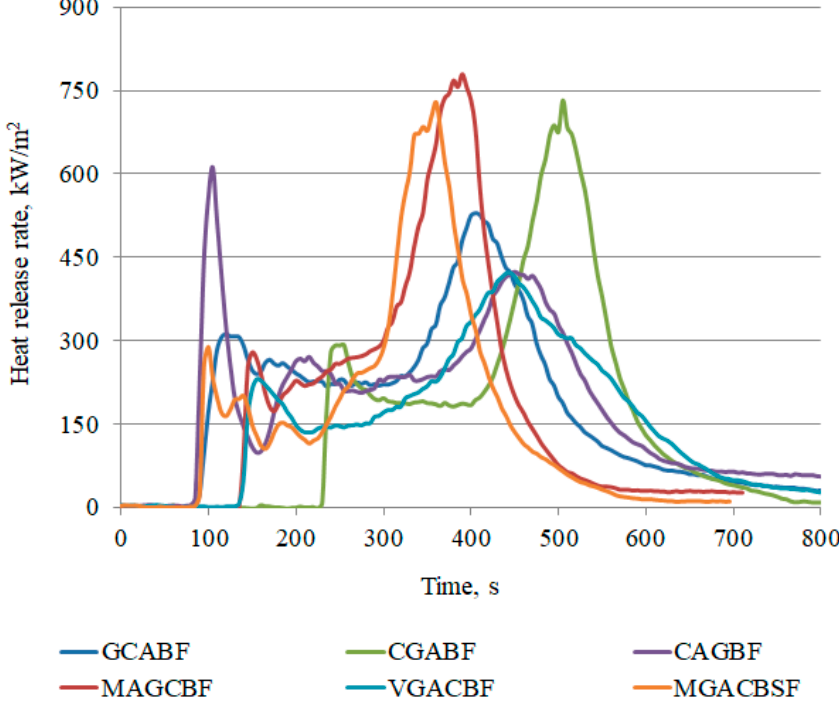
Figure 7. Representative curves of heat release rate of the EP-based composites. The time to ignition (TTI), which defines the time required for the ignition and main- tenance of the flame over the sample surface [29], achieved 94 to 142 s, and only for CGAB was significantly higher (172 s). However, the standard deviation in the case of these com- posites was also the highest. It should be emphasized that no significant trend associated with the sequence of fabrics was observed. On the other hand, the heat release rate, as the most evaluative factor among the fire properties, was ranging from 454 to 706 kW/m 2 , and the lowest values were obtained for composites with glass fabrics (GCABF) or vermiculite powder with glass fabric (VGACBF) as the outer layer. Since the amount of the epoxy resin, which is the most flammable component in investigated materials, was similar, it confirms the crucial influence of the type, form, and sequence of fabrics. For example, the replace of carbon fabrics with glass ones in CGCBF and GACBF composites decreased the pHRR by 38%, while glass spheres by vermiculite in MGACBSF and VGACBF decreased by 26%. This may be connected with the release of water, physisorbed in the vermiculite, that occurred due to the external heat flux impact and led to the exfoliation of V at an elevated temperature. Vermiculite, with a structural formula (Mg,Fe,Al) 3 (Al,Si) 4 O 10 (OH) 2 · 4H 2 O), is known for its flame retardant properties, related to the high resistance to heat and ability to water absorption [27,30,31]. Similarly, the lowest values of the maximum average rate of heat emission (MARHE), regarded as a parameter to estimate the hazard of fire spread [32], were obtained for VGACBF. In turn, the highest pHRR and MARHE were obtained for the composite, in which the outer layer contains mainly glass spheres and aramid fibers. No evident trend linking the form or sequence of the fillers with total heat release (THR) values can be observed. However, lower THR values were obtained for MGACBSF, VGACBF, and CGABF, in which under carbon fabrics or glass spheres and vermiculite are layers of glass and aramid. In turn, putting aramid fabrics as the second layer (CABGF, MAGCBF) or replacing carbon fabrics with glass ones (GCABF) led to increasing in THR. Unusually, a lower THR, considered a measurement for the fire load of material, suggests incomplete combustion due to the reduced combustion efficiency or formation of a char